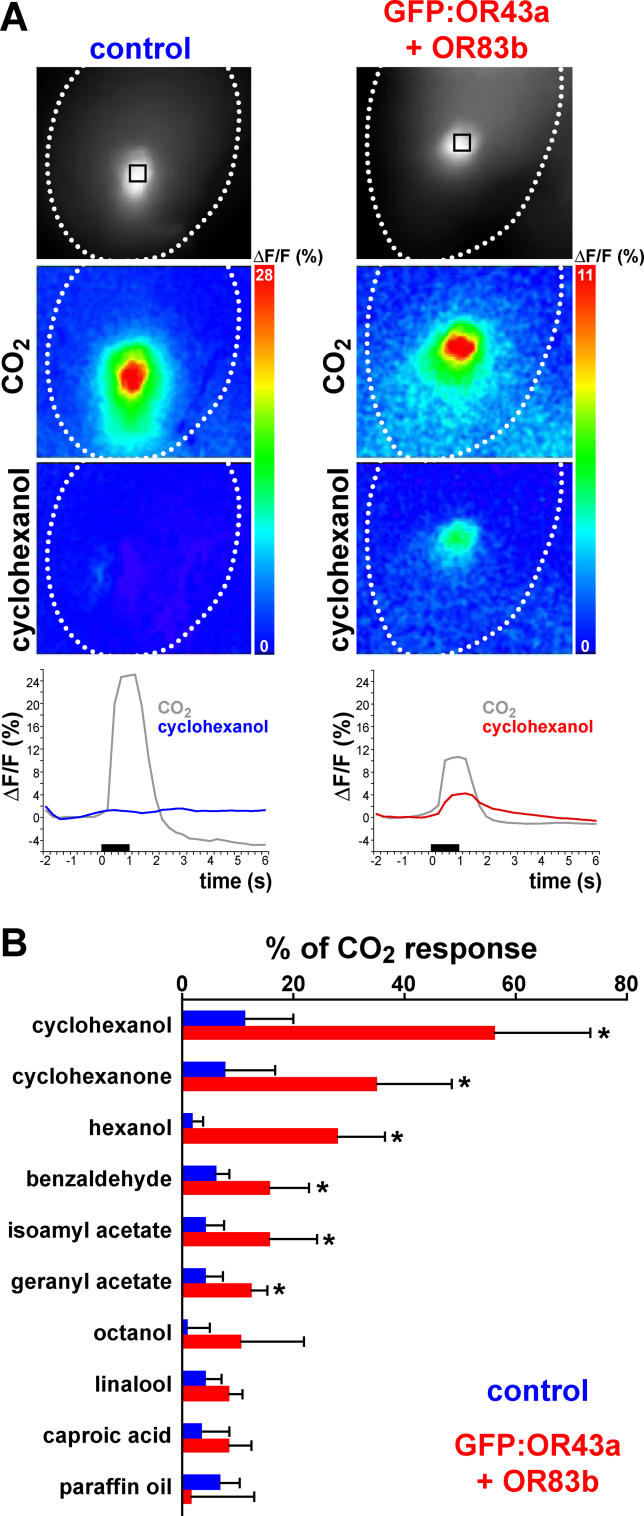
Expression of ORs and OR83b Reconstitutes a Functional OR in Gr21a Neurons(A) Representative stimulus-evoked calcium signals recorded from the axon terminals of Gr21a neurons in the antennal lobe V glomerulus of a control animal (UAS-G-CaMP/UAS-G-CaMP;Gr21a-Gal4/Gr21a-Gal4; left column) and an animal misexpressing OR83b and GFP:OR43a in Gr21a neurons (UAS-G-CaMP/+;Gr21a-Gal4/UAS-GFP:Or43a;UAS-G-CaMP/UAS-Or83b; right column). Top row: intrinsic G-CaMP fluorescence of the V glomerulus. Dotted lines mark the antennal lobe border, and the black squares mark the area of the V glomerulus evaluated for stimulus-evoked changes in fluorescence. Middle row: false-color–coded images during stimulation with CO2 (5%) or cyclohexanol (10−2) represent ΔF/F (%) according to the scales on the right panel. Bottom row: time traces of stimulus-evoked signals of the V glomerulus. Black bars indicate odor stimulation time. The diminished responses to CO2 in animals expressing GFP:OR43a/OR83b may reflect competition between the resident and ectopic receptors in engaging the ciliary trafficking pathway or downstream signaling components.(B) Normalized odor-evoked calcium responses of control (blue) and GFP:OR43a/OR83b-misexpressing (red) animals [genotypes as in (A)] expressed as a percentage of the CO2 response in each genotype. GFP:OR43a/OR83b-misexpressing animals show stronger responses than control animals for the odor stimuli (all at 10−2) marked with an asterisk (p < 0.05; two-tailed unpaired t-test; n = 4 animals per genotype and stimulus). Chemical Abstracts Service (CAS) registry numbers: cyclohexanol (108–93–0), cyclohexanone (108–94–1), hexanol (111–27–3), benzaldehyde (100–52–7), isoamyl acetate (123–92–2), geranyl acetate (105–87–3), octanol (111–87–5), linalool (126–91–0), caproic acid (142–62–1).